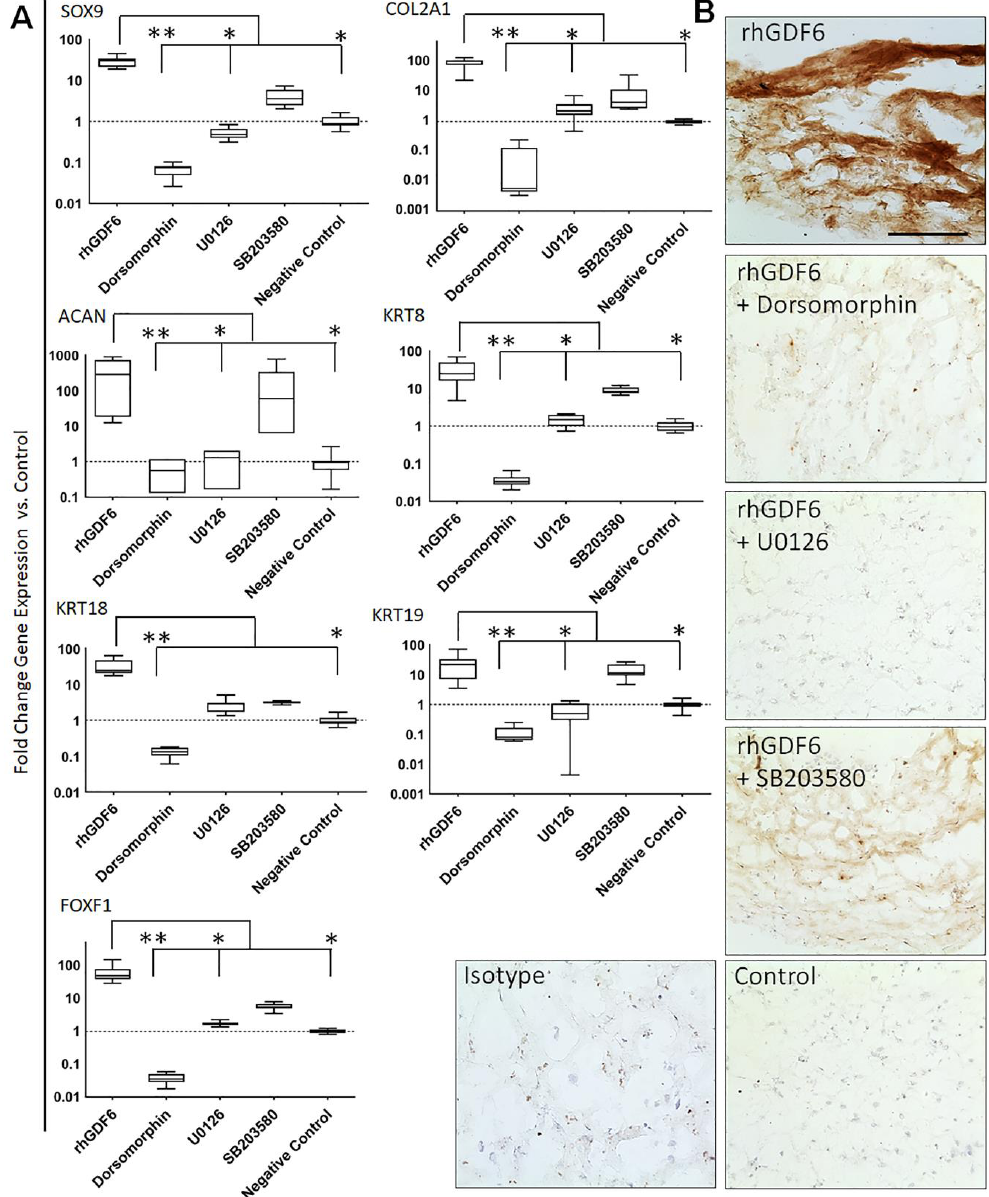
Figure 4. ( A ) QRT-PCR analysis of healthy NP gene expression in NP cells in response to 100 ng mL